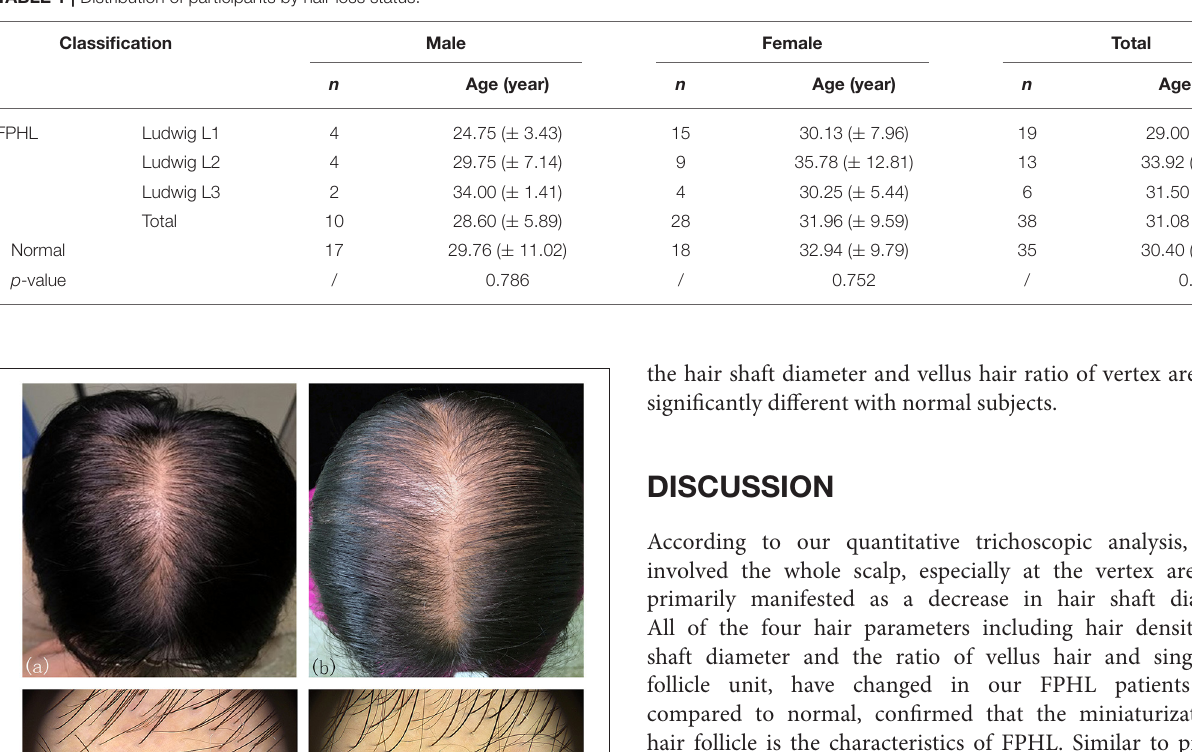
TABLE 1 | Distribution of participants by hair loss status.